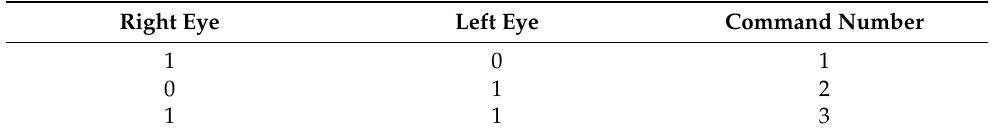
Table 3. Combining different voluntary blinks to generate three commands: “1” means one blink, “0” no blink. Right Eye Left